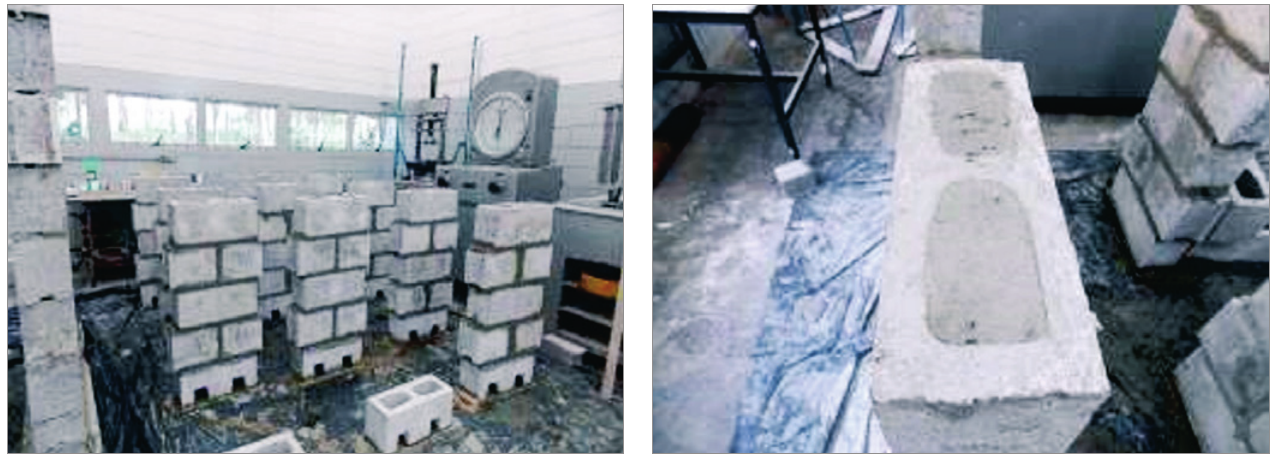
Ilustração dos prismas ocos e